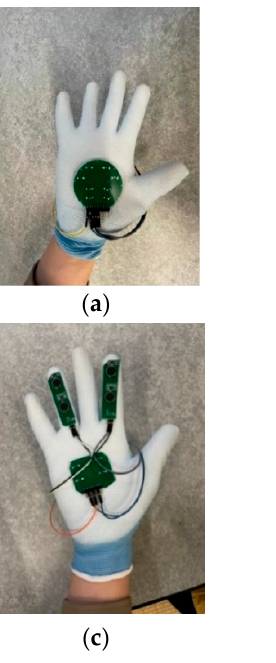
Figure 14. Two kinds of tactile display attached to the glove. ( a ) Tactile display 1 attached to the palm of the gloves. ( b ) Control circuits attached to back of gloves. ( c ) Tactile display 2 attached to the palm of the gloves. ( d ) Control circuits attached to back of gloves.